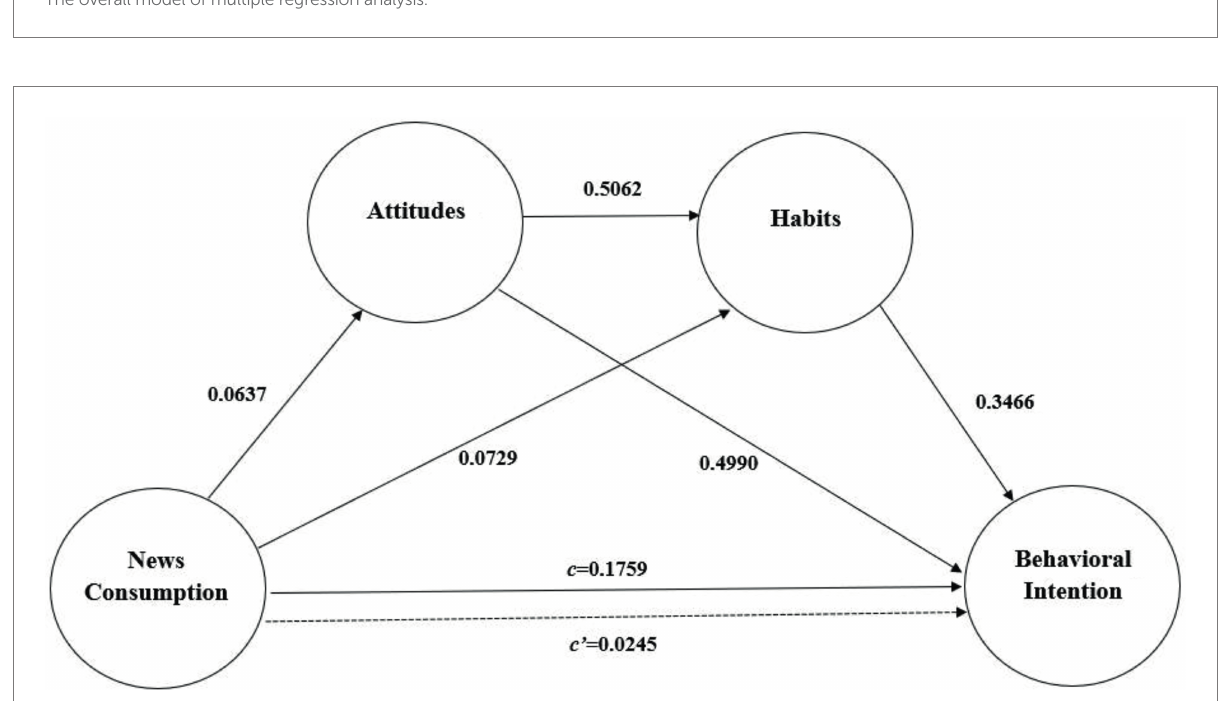
FIGURE 3 Path analysis of news consumption, attitudes, habits, and behavioral